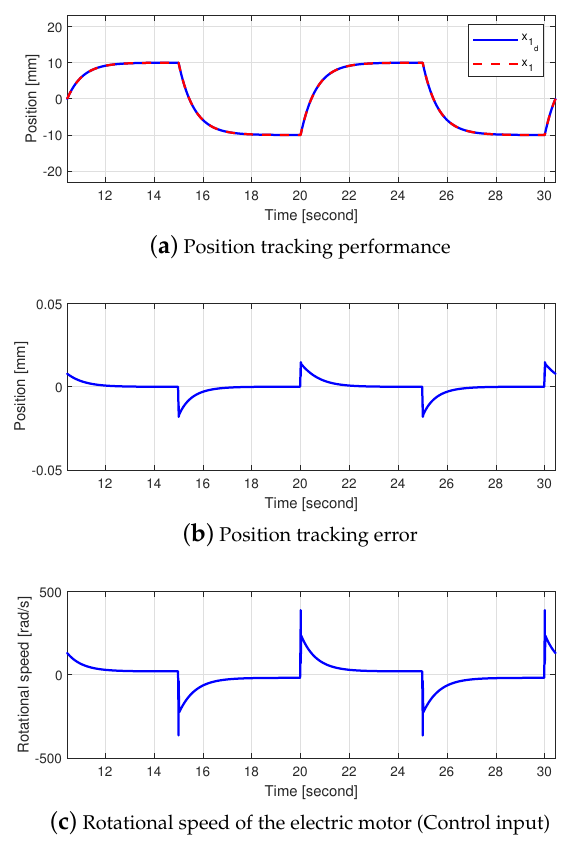
Figure 4. Position tracking performance of the proposed method in simulations with the trajectory reference.